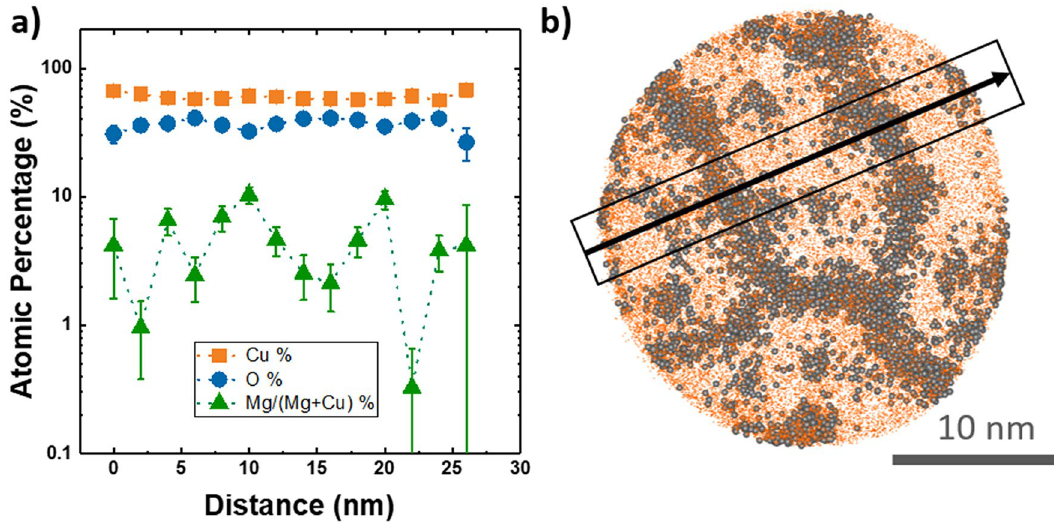
Figure 3. ( a ) Local atomic concentration profiles (Cu, O and Mg/(Mg + Cu) ratio) and ( b ) 2D ion map with Cu in orange and Mg in gray, extracted from a 10 nm thick slice taken across the APT specimen (plane-view of as-deposited Cu 2 O:Mg film) close to the position 4 indicated in Fig. 2a). The box and thick arrow indicate the location and direction of the profile shown in ( a